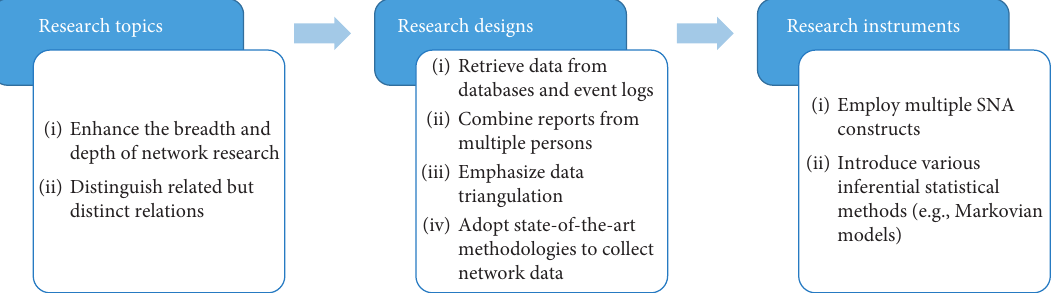
Figure 8: Future directions for network research in